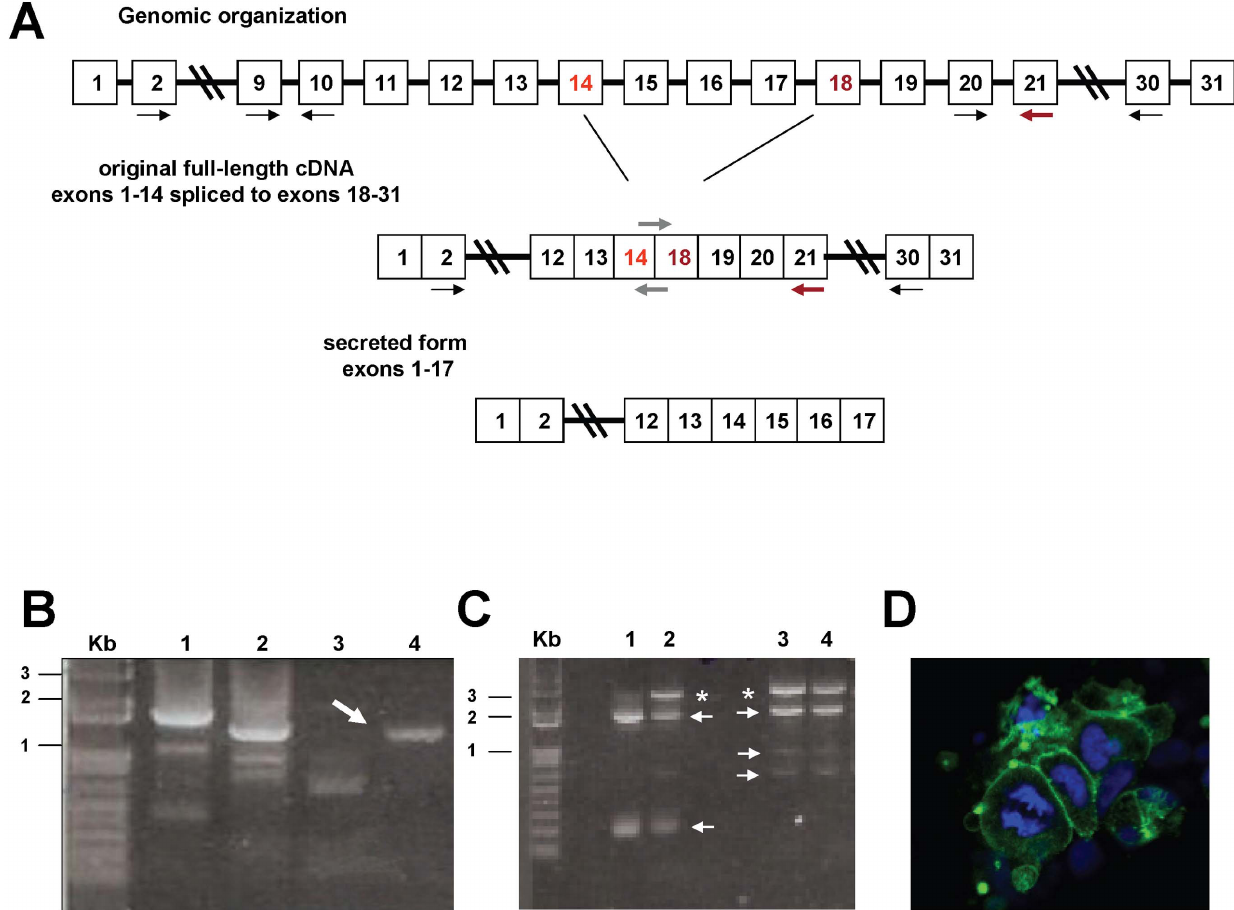
Figure 1. Original characterization of the candidate fuhc . A. Top shows an illustration of the genomic structure of the fuhc locus using our original exon numbering. Middle illustration represents the original full-length cDNA which encoded exons 1–14 spliced to 18–31. The secreted cDNA (exons 1–17) is shown on the bottom. Primers used in panels B and C are represented by arrows. Gray arrows represent primers which spanned the exon 14/18 boundary (see text). The red arrow was used for 5 9 RACE shown in panel B. B. Initial RACE results using original exon numbering. Sense primers for 3 9 RACE: lane 1, sense primer in exon 20; lane 2, sense primer in exon 9. For 5 9 RACE, Lane 3 is an amplicon using an antisense primer in exon 10, In lane 4 the antisense primer was in exon 21 (red arrow in panel A; middle). Sequence from the RACE product in Lane 4 (white arrow) was the original evidence for alternative splicing. It should have amplified a 373 bp fragment (to the front of the fuhc tm mRNA), but instead amplified a product that spanned the two genes. C. Amplification of the full-length gene from primers in exon 2 and exon 30 from cDNA isolated from 4 wild- type genotypes. The expected 3.2 Kb full-length product is amplified (asterisks), as well as several smaller products which encoded splice variants missing various exons but still linking the two genes (arrows). D. Retroviral expression of exons 1–27 of the original transmembrane gene fused to EGFP in mammalian 293T cells. The protein (green) is targeted to the plasma membrane, suggesting it is folding correctly and transiting the secretory pathway normally. Nuclei are counterstained with